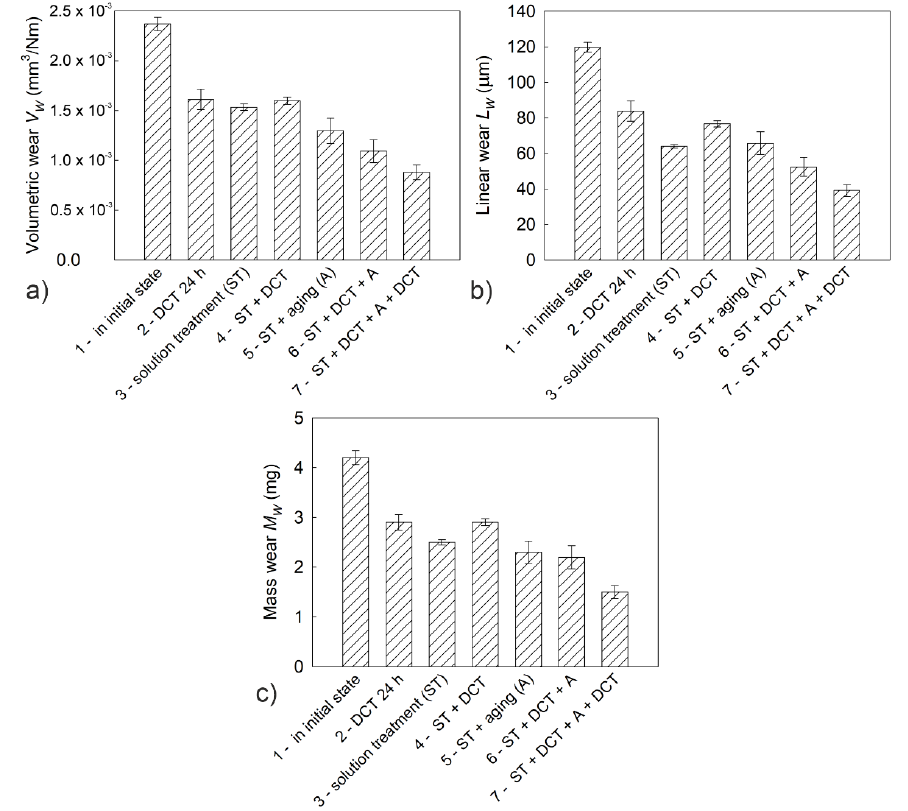
Figure 11. Volumetric wear ( a ), linear wear ( b ), and mass wear ( c ) of the Mg-Y-Nd alloy in the initial state and after different heat treatment variants in combination with DCT.